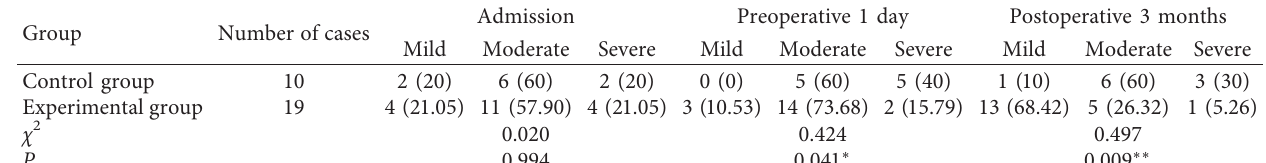
Table 3: Comparison of patient anxiety.